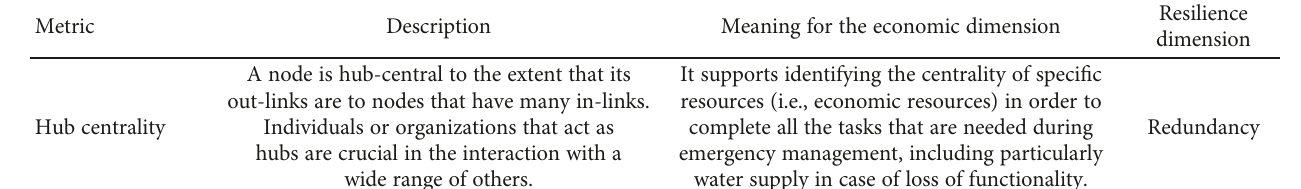
Table 7: Economic dimension of resilience: GT measures related to the soft infrastructural system.